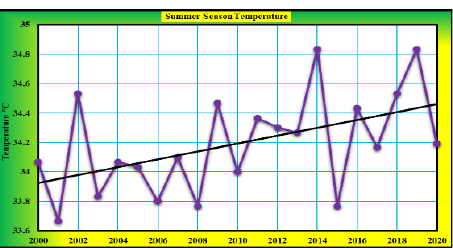
Figure 9: Represents Annual Average Temperature Trend Line in the Ghotki district 2000-2020